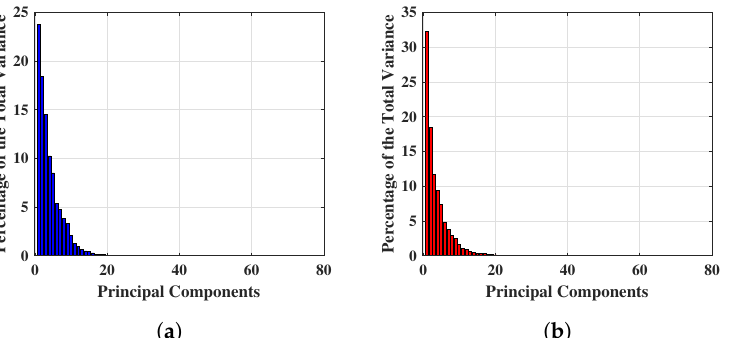
Figure 4. Example of significant variance achieved applying PCA on complex S 21 signals. ( a ) Signifi- cant variance achieved applying PCA on complex S 21 signals of a NF breast. ( b ) Significant variance achieved applying PCA on complex S 21 signals of a WF breast.